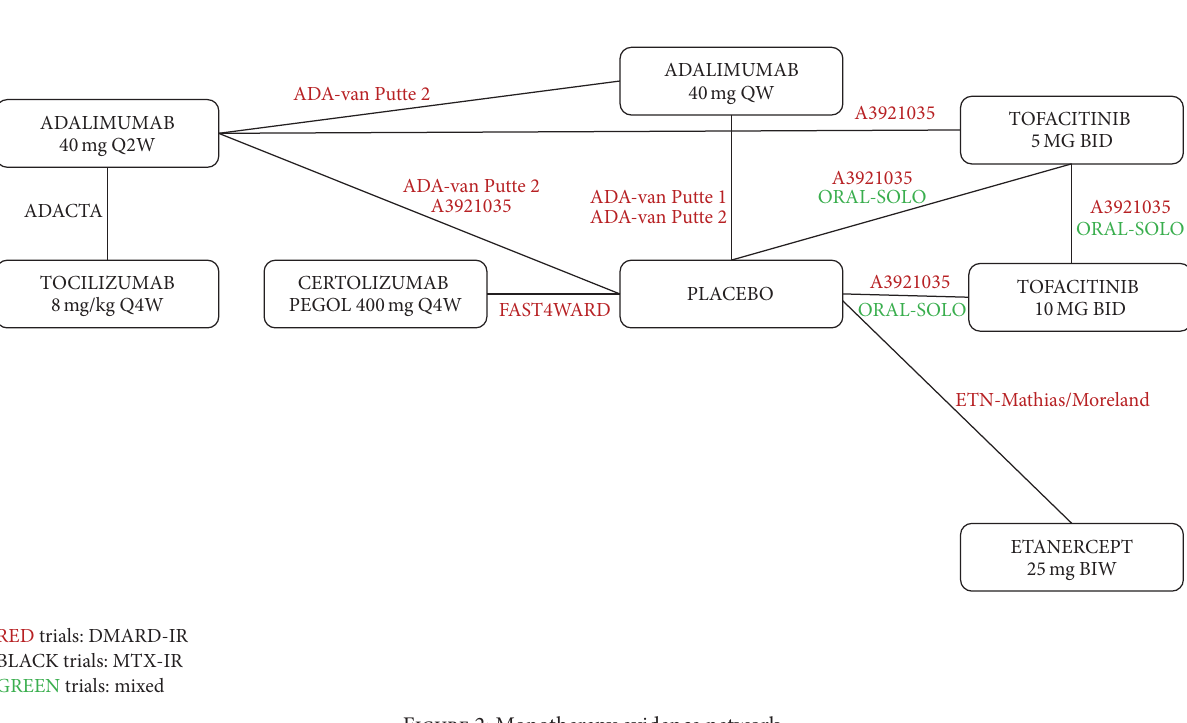
Figure 1: Flow diagram.